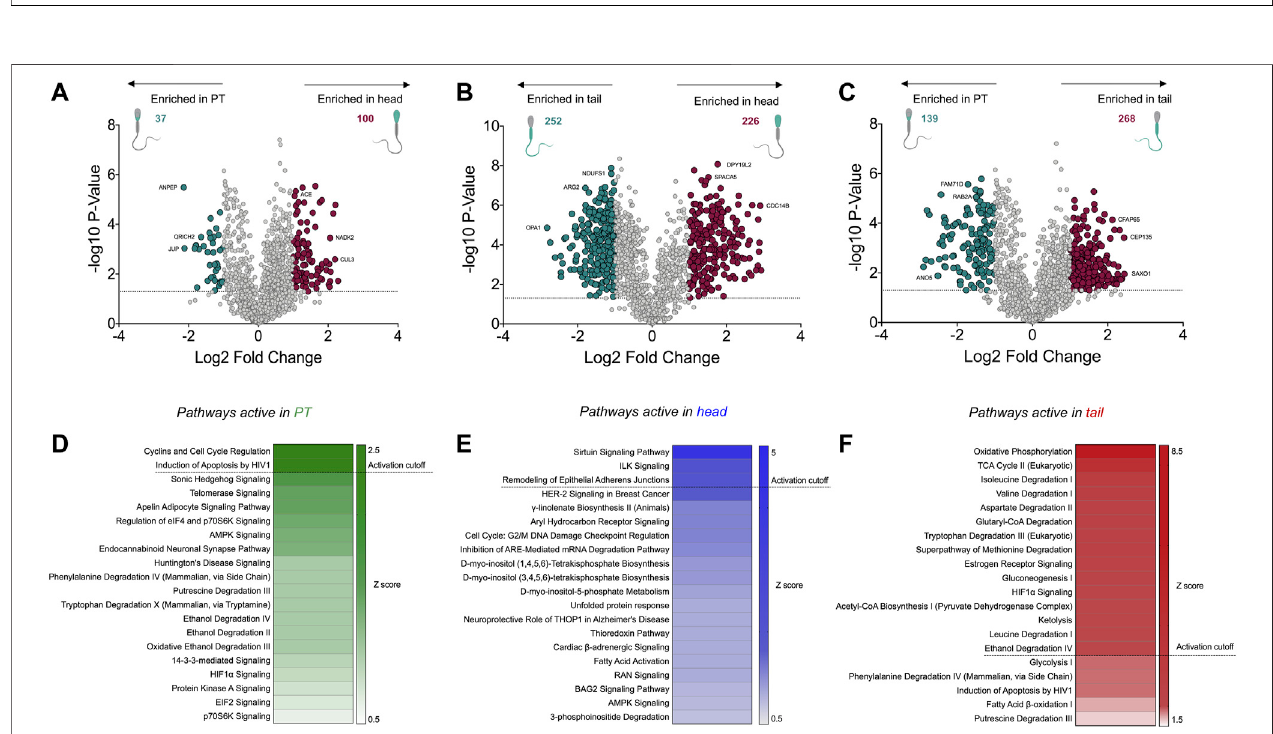
FIGURE 7 | Signi fi cantly enriched proteins within the perinuclear theca compared to the sperm head and tail, and functional analyses of the cell compartment proteomes. (A – C) Fold changes and p -values were calculated from abundance values for each protein detected in the perinuclear theca (PT), head and tail. In this analysis a protein was deemed to be signi fi cantly enriched in each sample type upon meeting a fold change cut off of ≥ 2 and a p -value of ≤ 0.05 (dotted line). In the volcano plot visualizations these cut offs are equivalent to a log2 fold change of ≥ 1 and a − log10 p -value ≥ 1.3. Proteins that meet these criteria were designated colors (red and green) in panels (A – C) . (D – F) The Z-score function within Ingenuity Pathway Analysis (IPA) software was used to predict active pathways within each sample type. A Z-score ≥ 2 indicates the likely activity of the pathways listed in panels (D – F) .